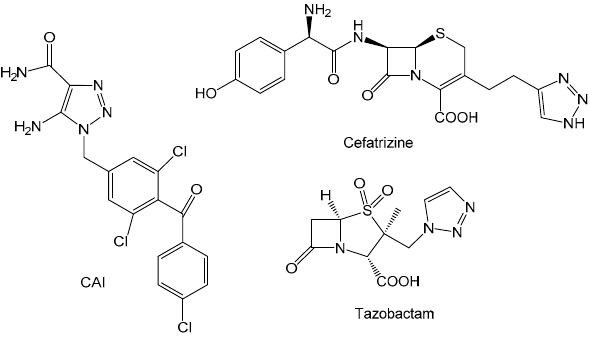
Figure 1. Potential pharmaceuticals based on 1,2,3-triazoles.